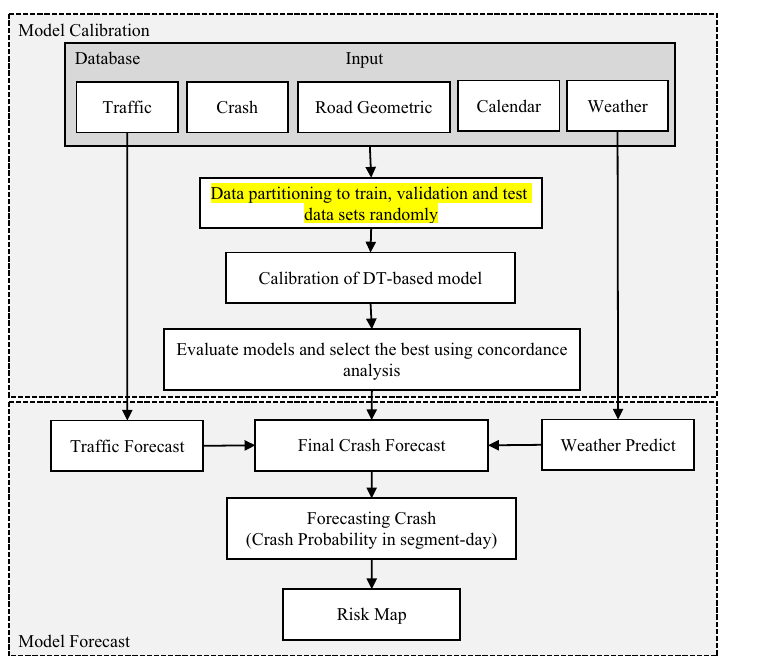
Figure 3. Flowchart for the procedure of generating crash risk